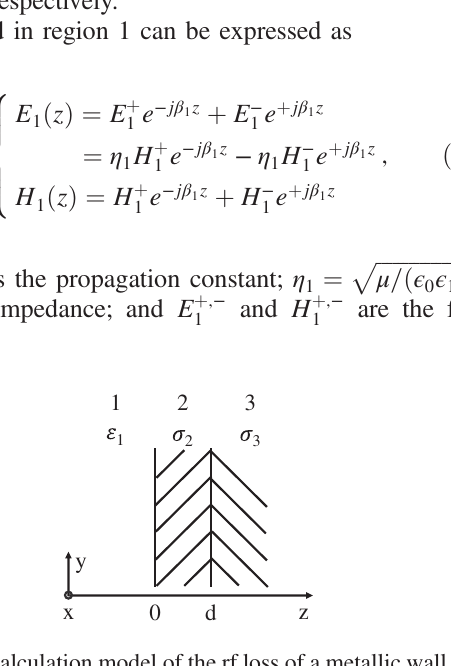
FIG. 18. Calculation model of the rf loss of a metallic wall with a thin